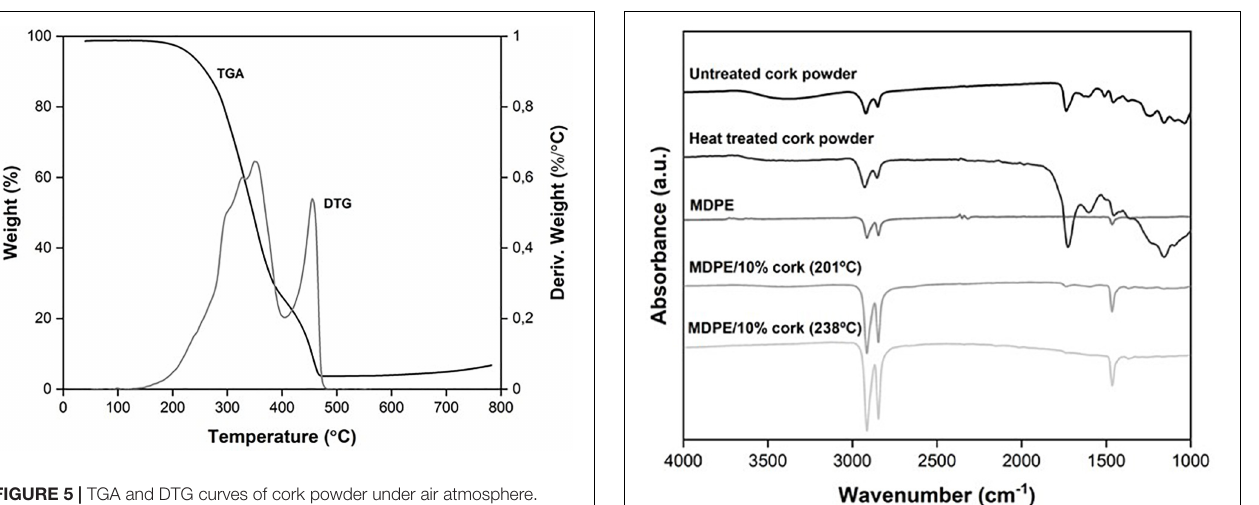
FIGURE 5 | TGA and DTG curves of cork powder under air atmosphere.